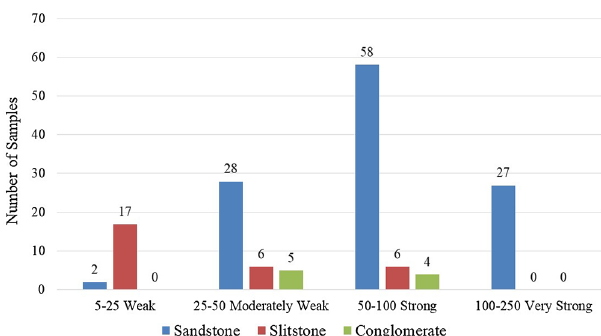
Figure 3. Classification of the uniaxial compressive strength of tested